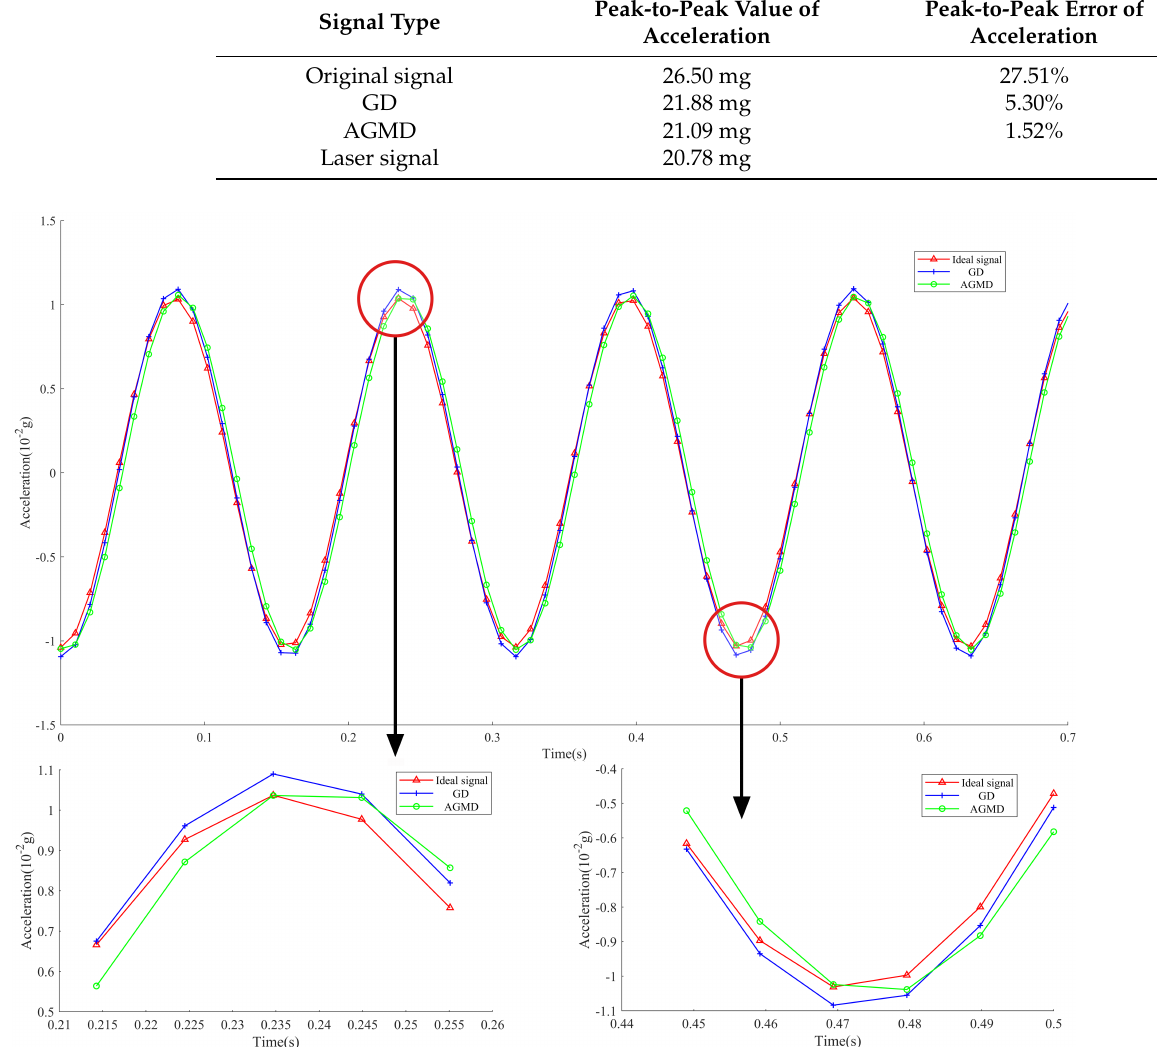
Figure 15. Comparison of acceleration time curves after algorithm